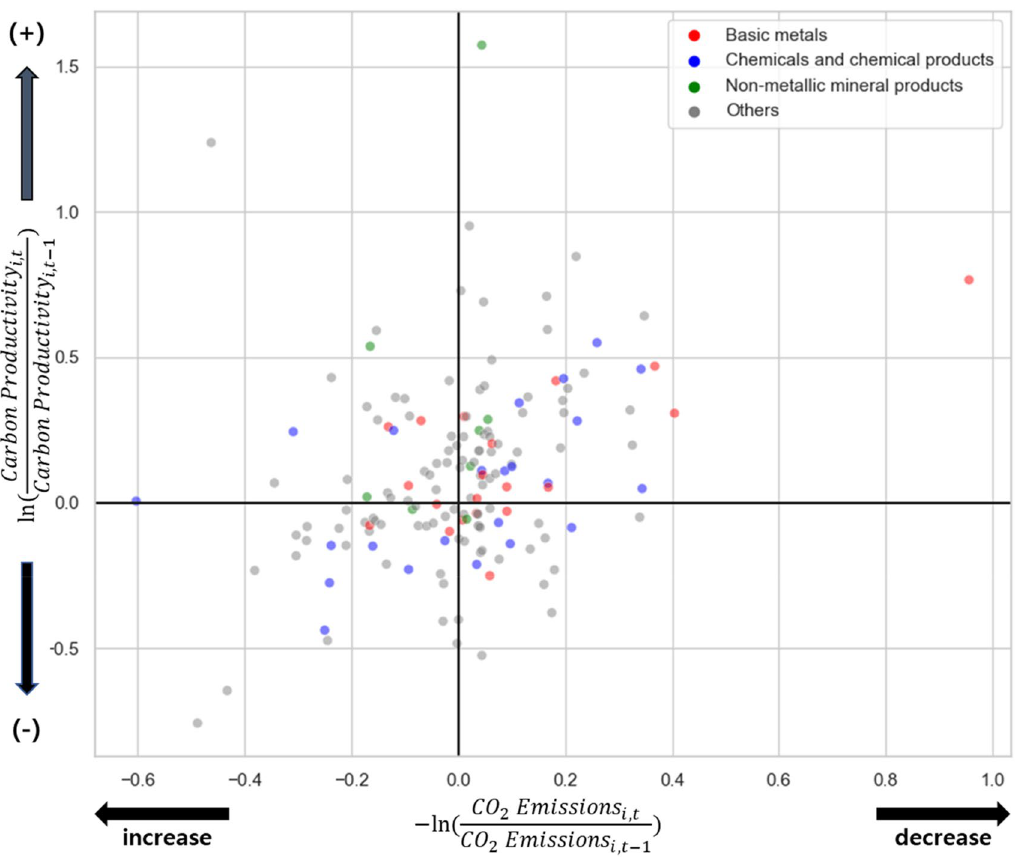
and blue indicates the third highest.